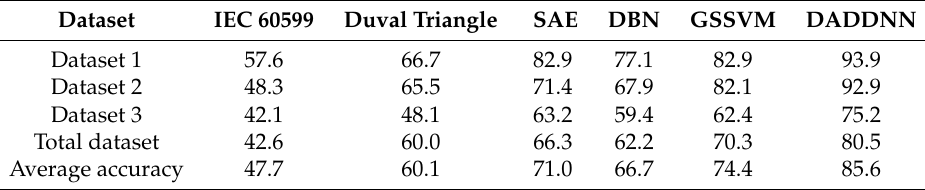
Table 2. Diagnosis accuracies of various methods under different datasets (%).